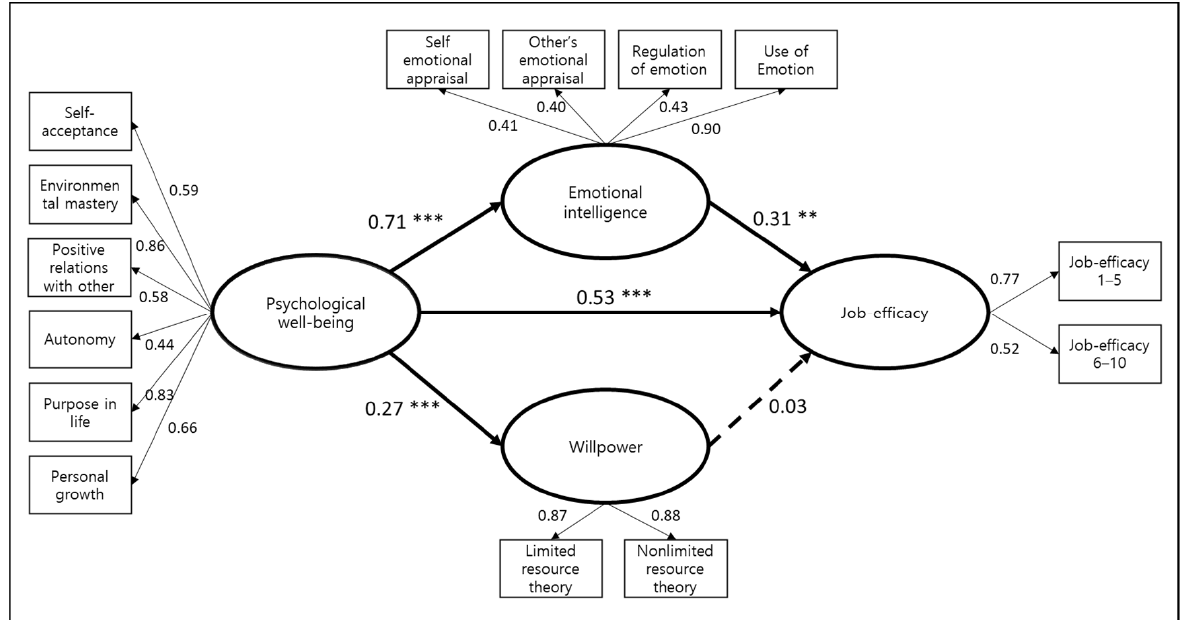
Figure 2. Final model. Note: ** p < 0.01, *** p < 0.001